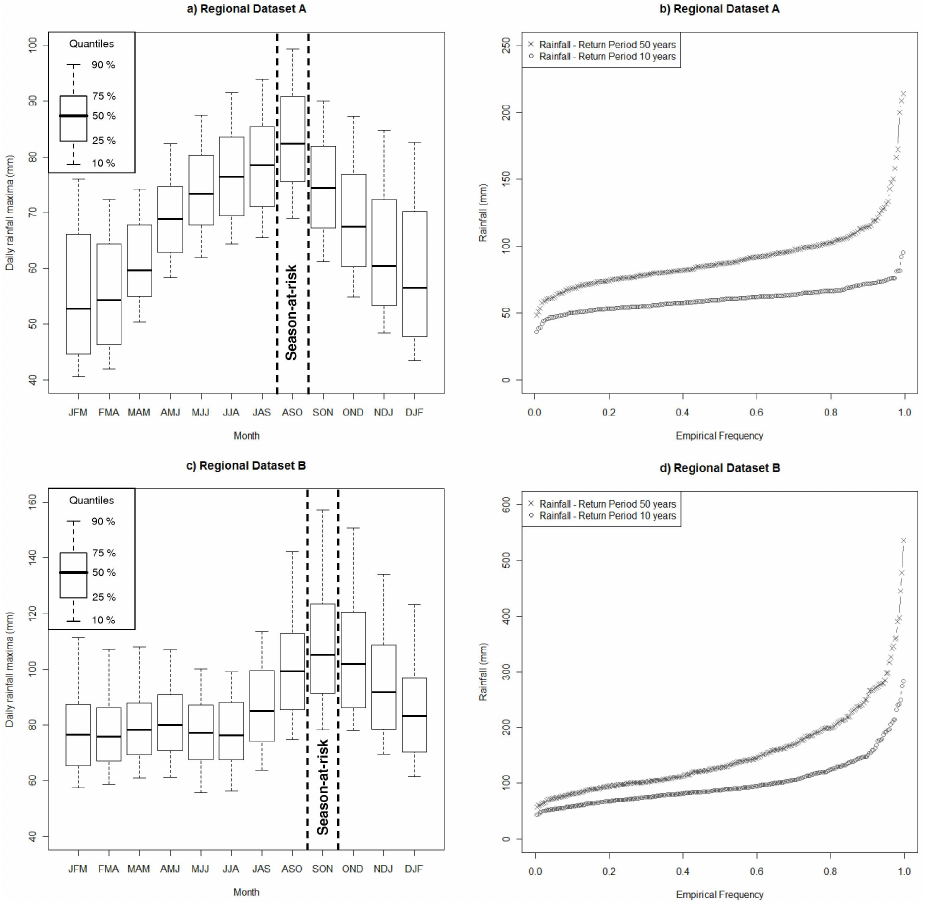
Fig. 2. Box plot of the three consecutive monthly rainfall maxima of regional dataset A (a) and regional dataset B (c) . Empirical distribution of rainfall quantile estimates associated with 10- and 50-year return periods for regional dataset A (b) and regional dataset B (d)